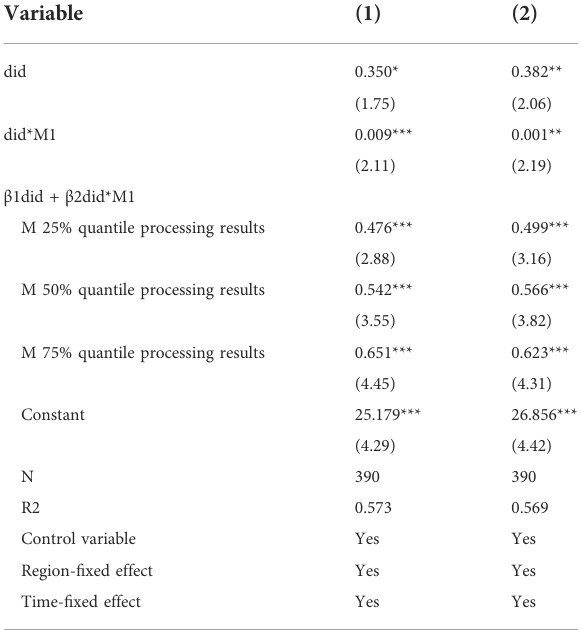
TABLE 8 Regression results of further assessment.